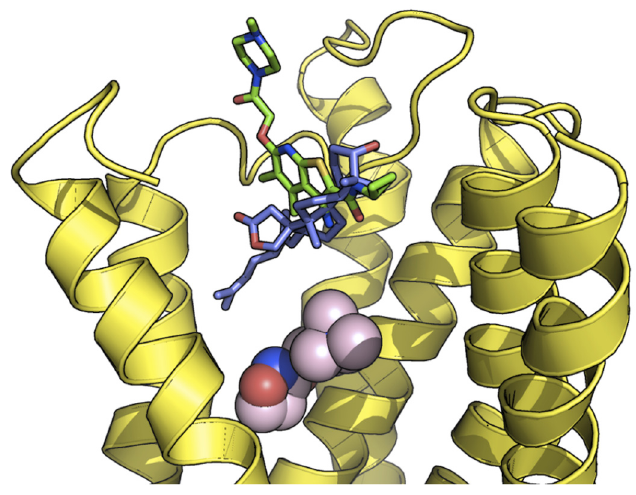
Fig 6. Superposition of ebelin lactone (blue) in complex with the M 1 mAChR model and LY2119620 (green) in complex with the M 2 mAChR. Superposition of the crystal structure of the allosteric modulator LY2119620 in complex with M 2 mAChR (PDB code: 4MQS) with the docked ebelin lactone in M 1 mAChR shows the overlapping binding positions of these ligands, suggesting ebelin lactone could be a M 1 allosteric modulator. Iperoxo is shown in spheres to depict the orthosteric site of the